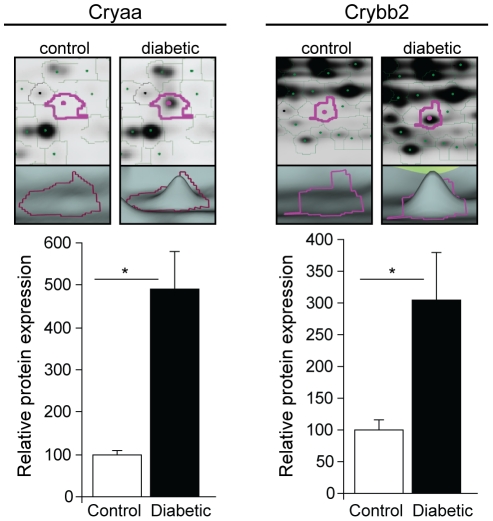
Examples of differentially expressed proteins identified by DIGE.Retinal protein isolated from three-month diabetic and age-matched control rats was separated and quantitated by DIGE analysis with identification by MS/MS. Two examples of confidently identified, differentially regulated protein spots are shown. The upper panels depict spot location and signal intensity, while the lower panels depict three-dimensional representations of the densitometric spot volumes used for quantitation. Both Cryaa and Crybb2 crystallin isoforms were significantly increased in expression (by 491% and 305%, respectively) in diabetic rats compared to controls. * p<0.05, two-tailed t-test, n = 8/group.